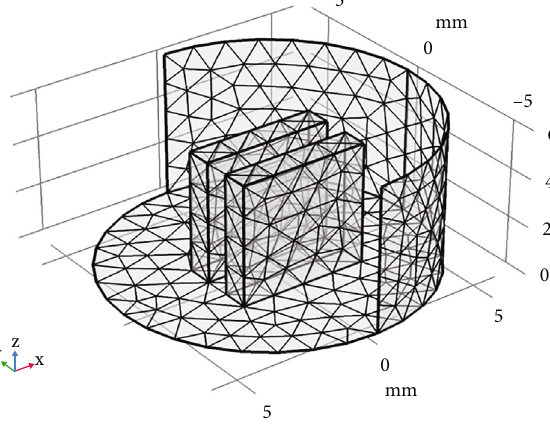
Figure 8: Free tetrahedral meshing geometry. Table 2: Meshing